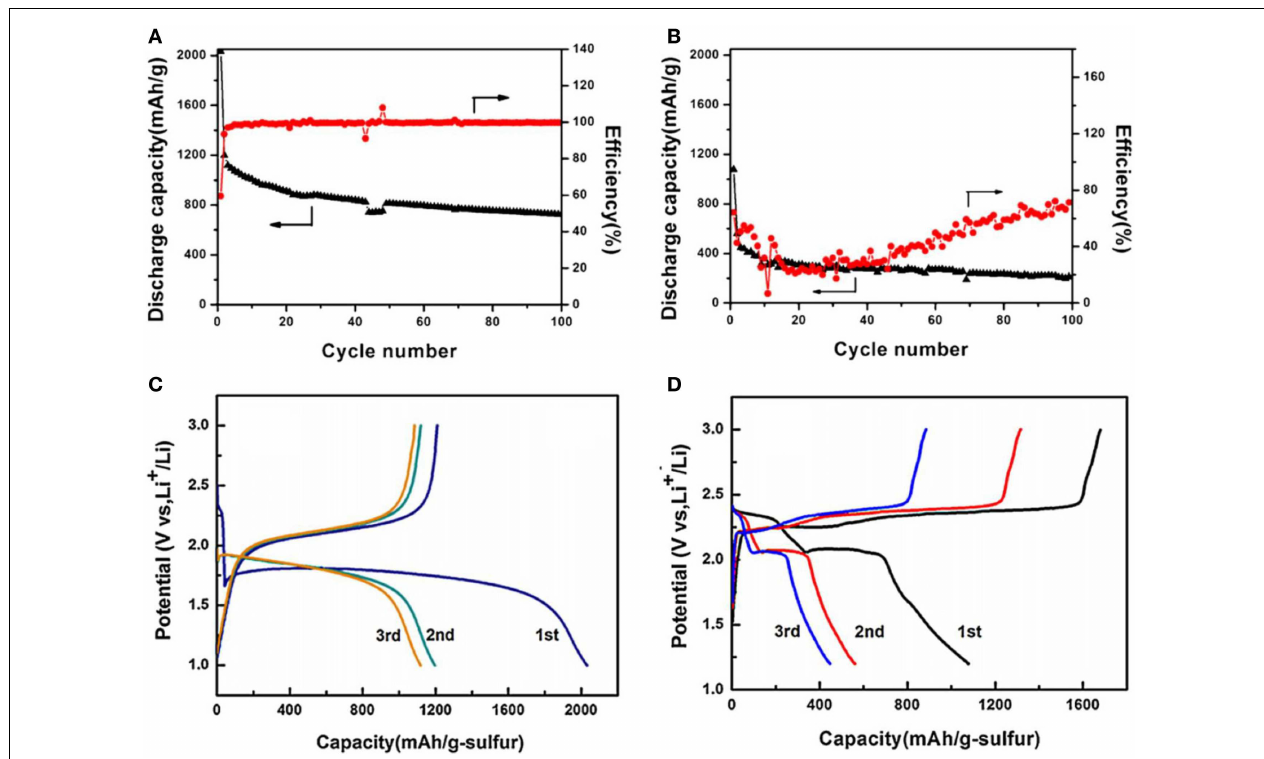
FIGURE 2 | Cycling performance of Li/SC cells at 100mA/g in a 1M LiPF 6 -PC-EC-DEC electrolyte (A,C) and a 1M LiTFSI-DME-DOL electrolyte (B,D), respectively . Reproduced with permission of Zhang et al. (2013).